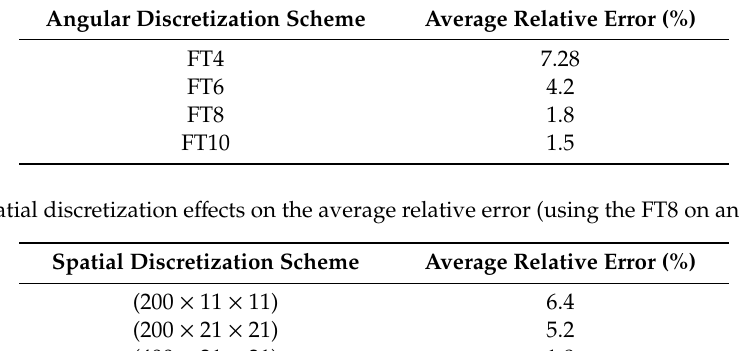
Table 4. Angular discretization e ff ects on the average relative error (using 400 × 21 × 21 on spatial mesh).